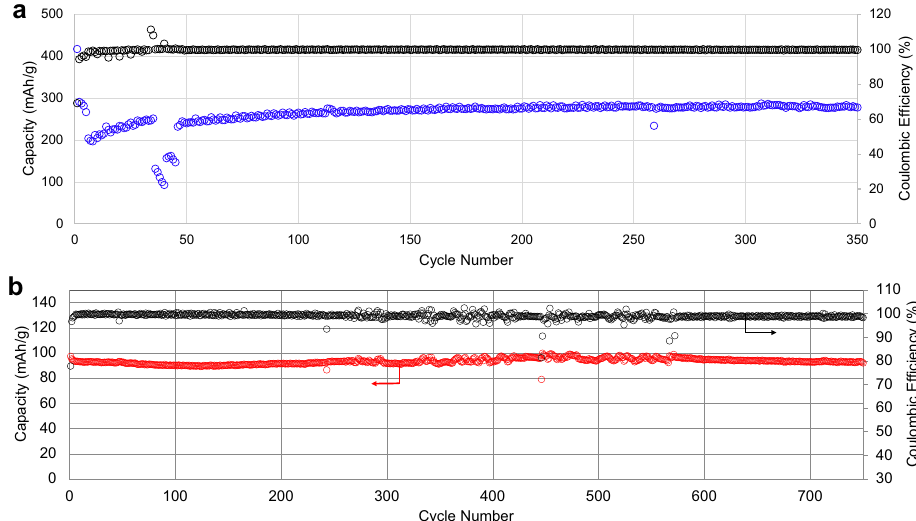
Fig. 3 Long-term cycling of lithium half-cells with waterglass binder. a Graphite electrode showing a rate capability test followed by stable long-term cycling at C/5. b Lithium – iron phosphate electrode cycling test at